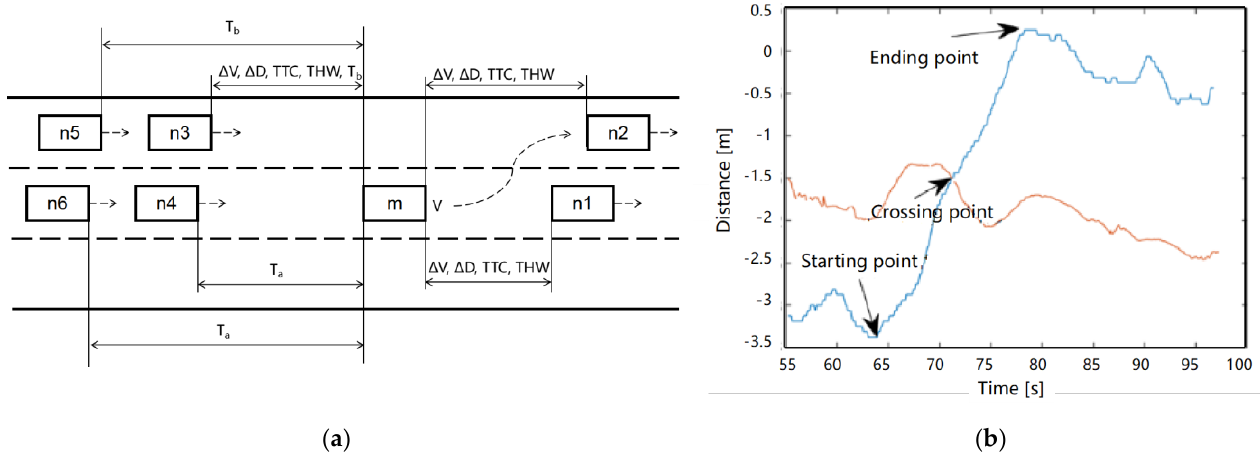
Figure 2. Lane change ( a ) participant definition and ( b ) moment definition.